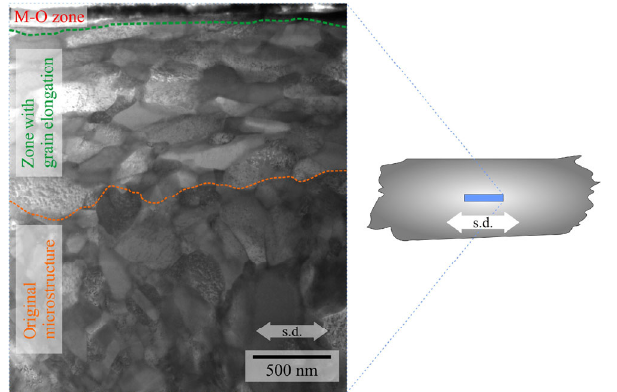
Fig. 12 Transmission electron micrograph of the sub-surface of the bm sample after 5,000 cycles under a 5 N load. The TEM foil was taken along the sliding axis at the center of the wear track, as shown in the schema on the